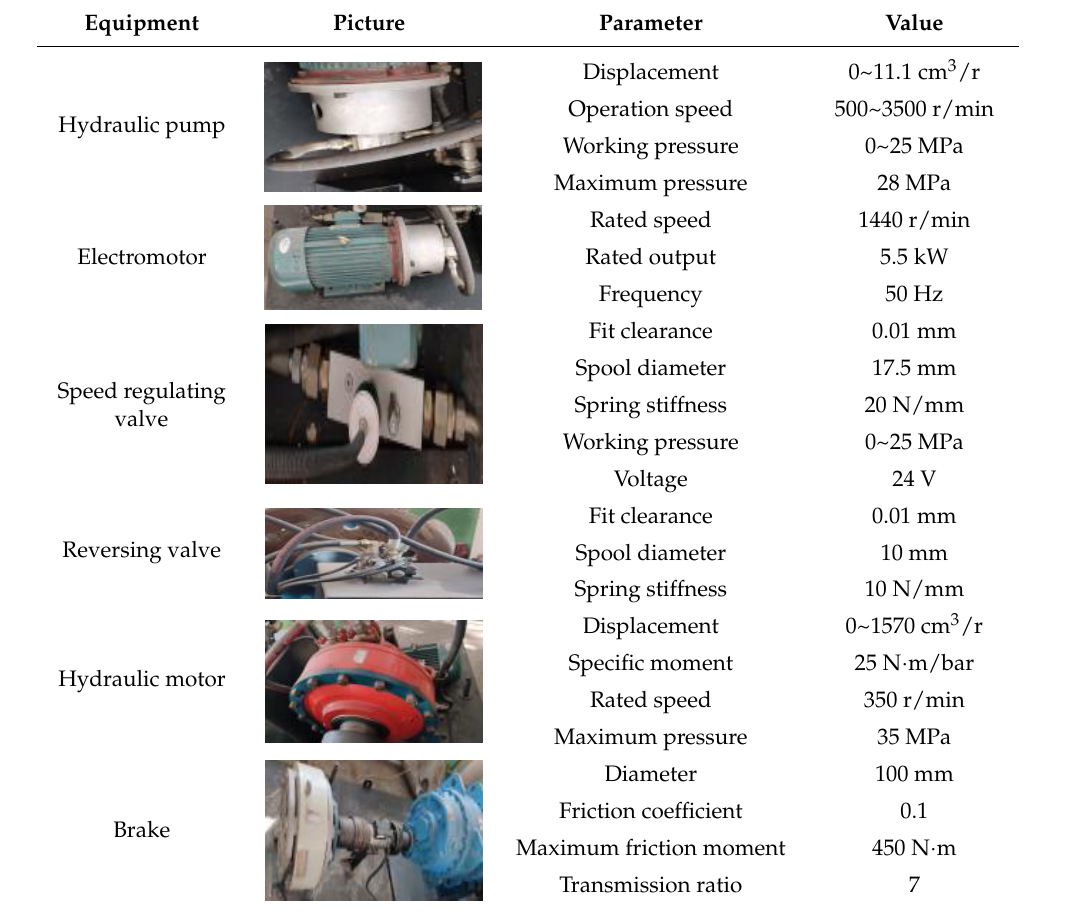
Table 2. Parameter of sail slewing hydraulic testbed and simulation model.